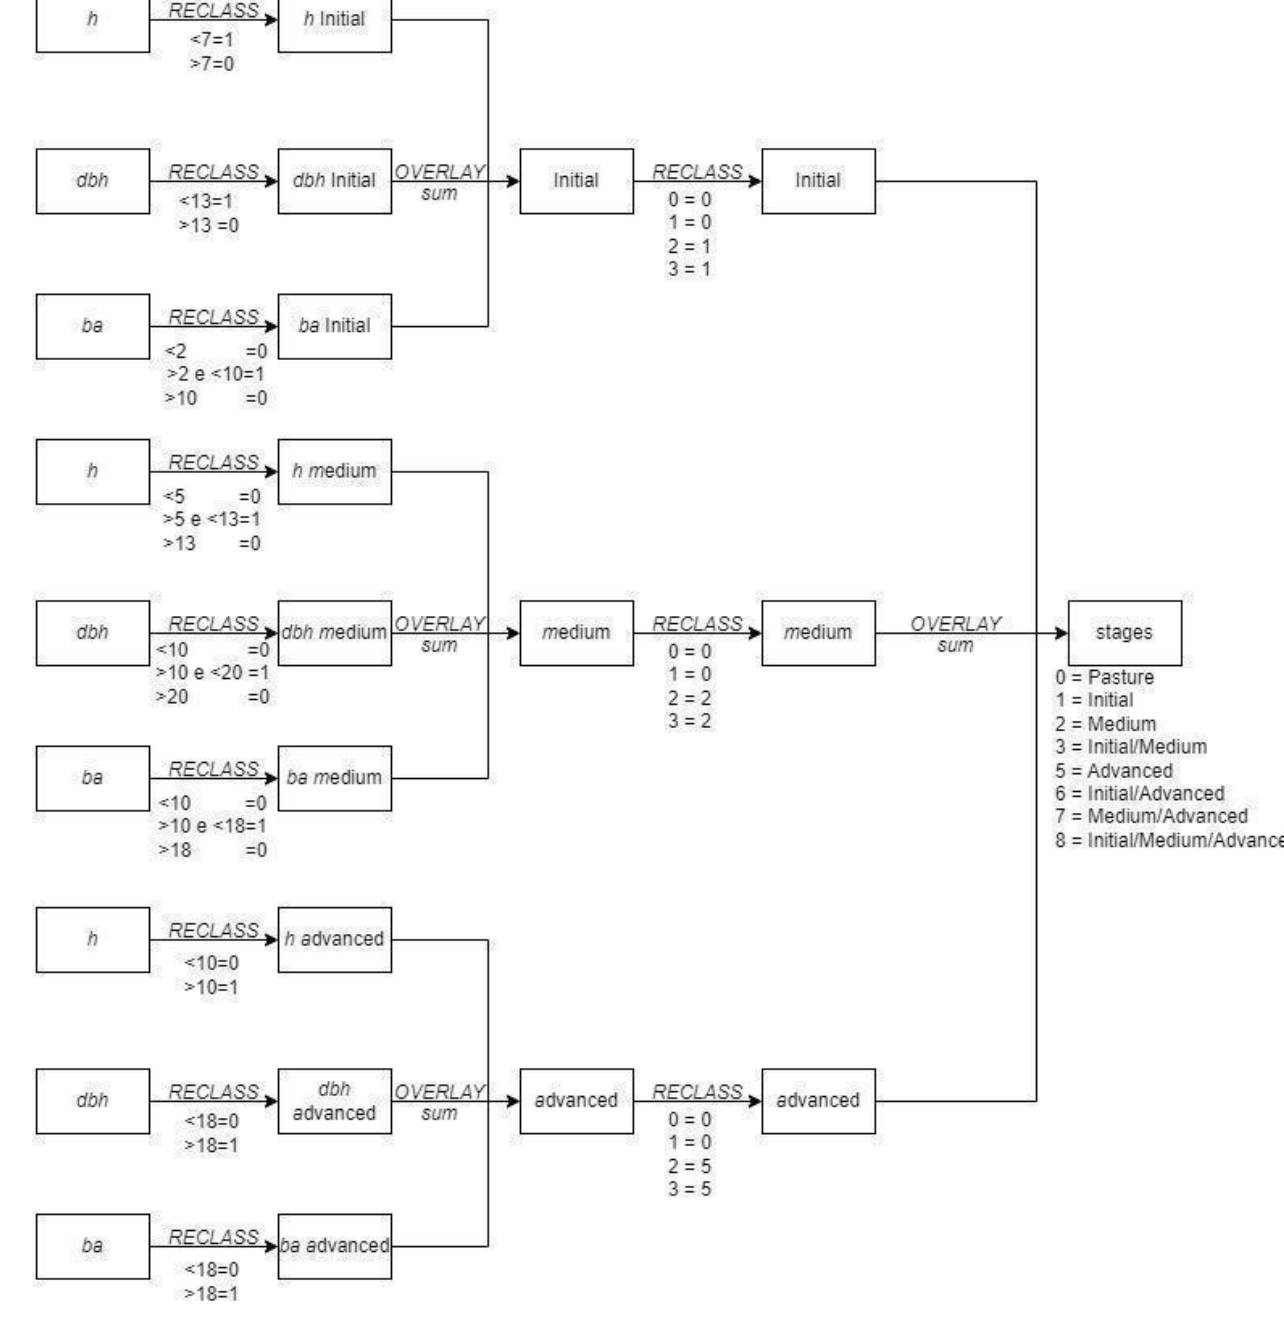
Figure 4. Succession stage classification flowchart.